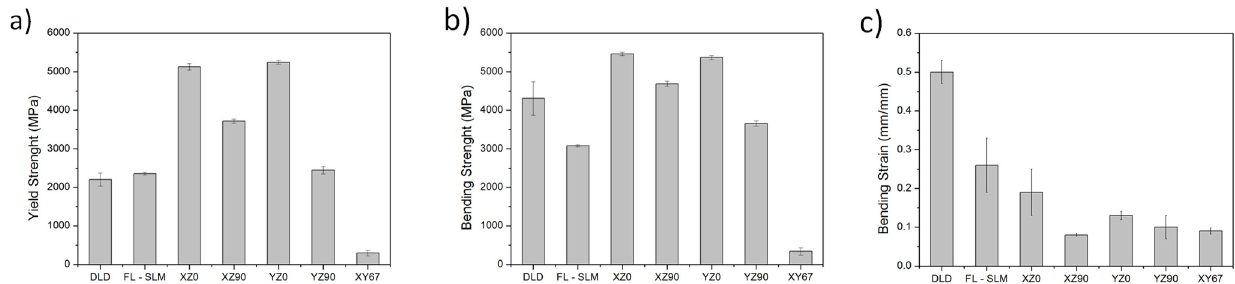
Figure 13. Bending test results of the AM samples: ( a ) yield strength, ( b ) maximum flexural strength, and ( c ) maximum flexural strain.